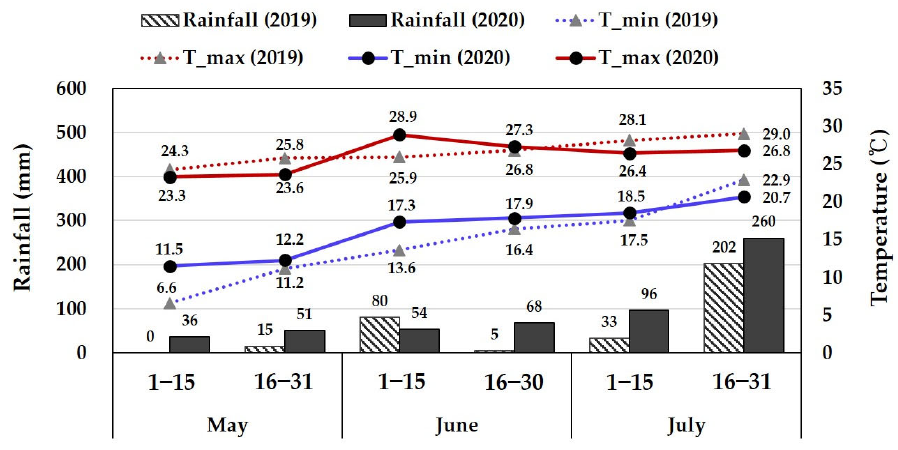
Figure 1. Distribution of rainfall and minimum and maximum temperatures of two years (2019–2020). The data were obtained from the Korean Meteorological Administration.